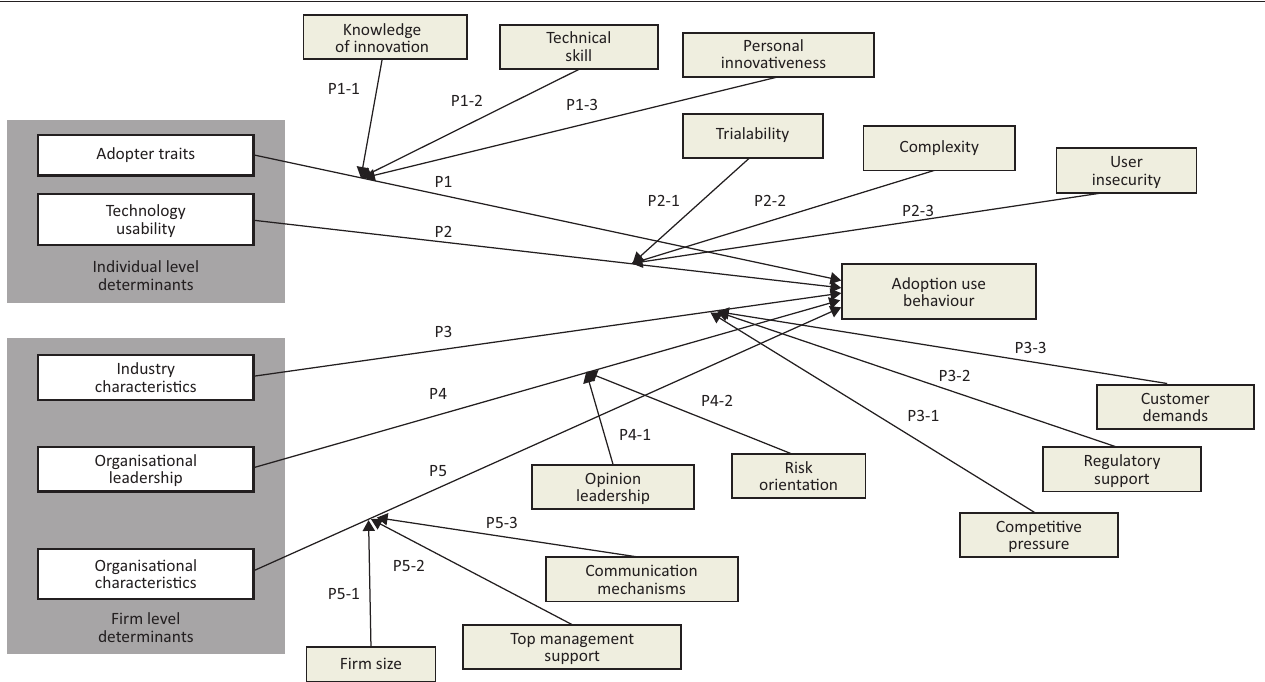
FIGURE 1: Conceptual model for the adoption of fourth industrial revolution technology in the South African financial